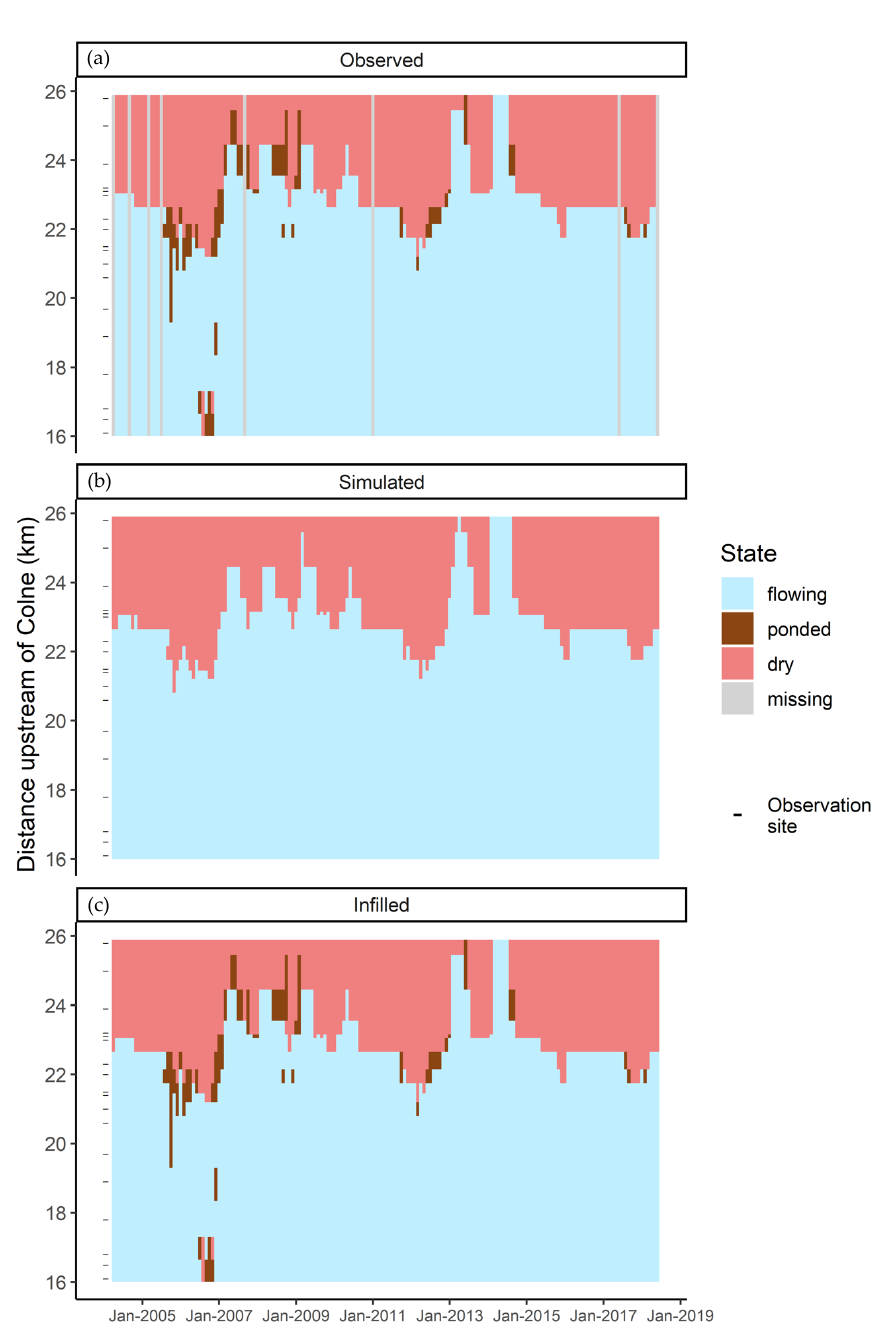
Figure 4. Monthly time series of observed ( a ), simulated ( b ), and infilled ( c ) hydrological state on the Gade, where infilled states are observations where available and simulations where observations are unavailable. Hydrological state is assumed to be consistent along observed reaches due to the high spatial resolution of the data.